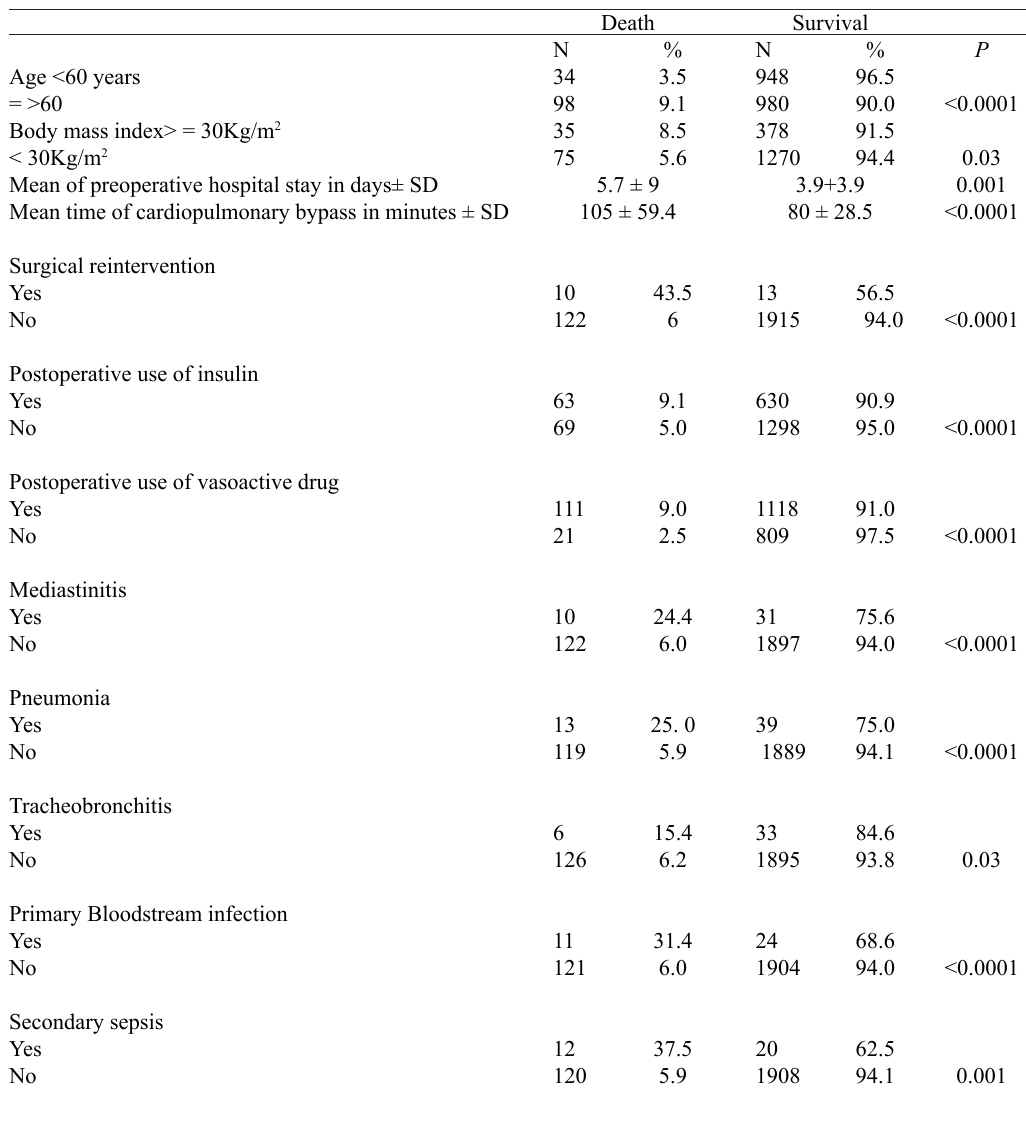
Table 6. Variables associated with the occurrence of non-surgical infection in logistic regression analysis. Age > = 60 years ICU stay > 2days Use of urinary catheter ≥ 3days Mechanical ventilation ≥